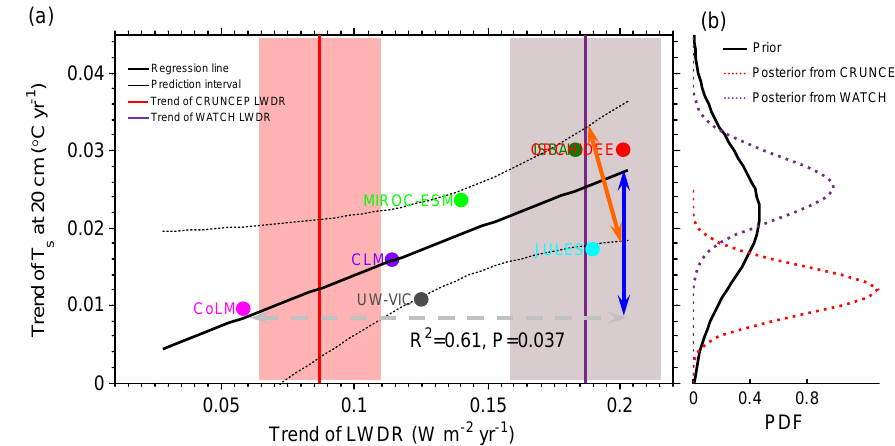
Figure 8. (a) Simulated trends of annual T s at 20cm and annual LWDR in the climate-forcing data over boreal regions across the seven models which used and provided LWDR in their climate forcing. The thin black dotted lines indicate the linear regression and 95% confidence interval. The gray dashed line with double arrows indicates the uncertainty of the trend of LWDR in the climate-forcing data. The solid blue and orange lines with double arrows indicate FU and SU, respectively. The red solid vertical line with a shaded area shows the trend of LWDR (0.087 ± 0.023Wm − 2 yr − 1 ) during the period 1960–2000 from the CRUNCEP v5.2 data set. The purple solid vertical line with a shaded area shows the trend of LWDR (0.187 ± 0.028Wm − 2 yr − 1 ) during the period 1960–2000 from the WATCH data set. (b) The prior normal probability density function (PDF) with modeled mean and standard deviation (black solid line) of the trend of T s at 20cm and posterior normal PDF of the trend of annual T s at 20cm with the given trend of LWDR (red dotted line) from CRUNCEP and WATCH (purple dotted line),